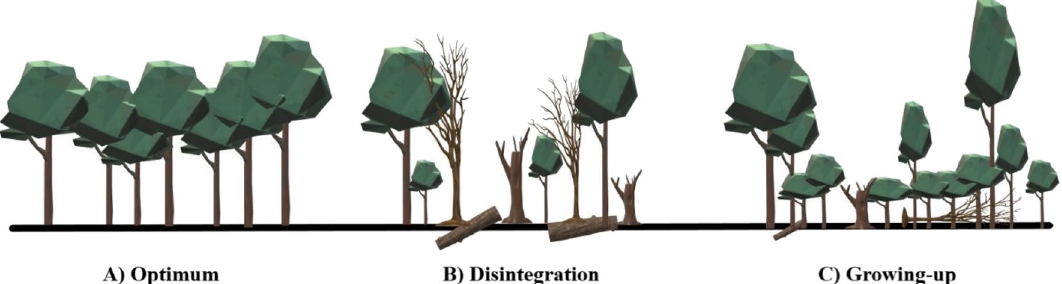
Figure 2. Schematic drawing of the developmental stages of beech forests with their typical structure. The schematic drawing was created in the Paint 3D application (Microsoft, Win10).